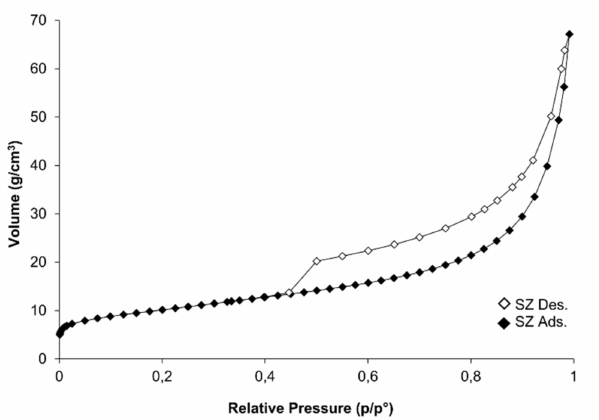
Figure 5. Comparison of N 2 adsorption and desorption isotherms for the synthetic zeolite (SZ)